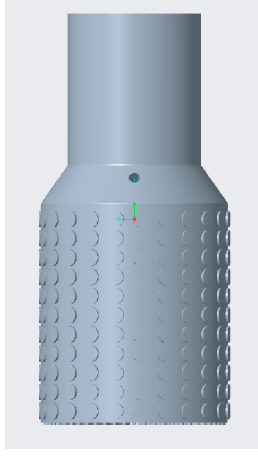
Figure 2. Muffler water body.